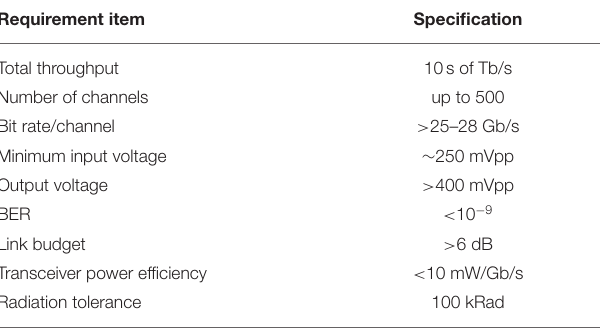
TABLE 1 | Top-level requirements for payload digital transceivers. TABLE 2 | Key metrics for transceiver.